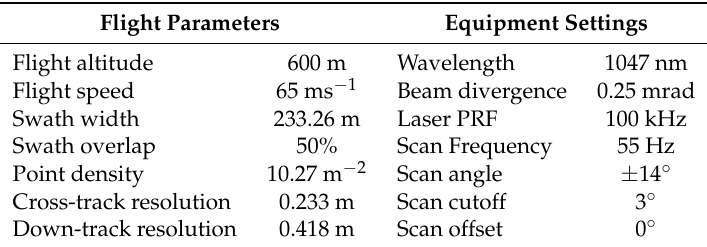
Table 2. Flight parameters and sensor settings a